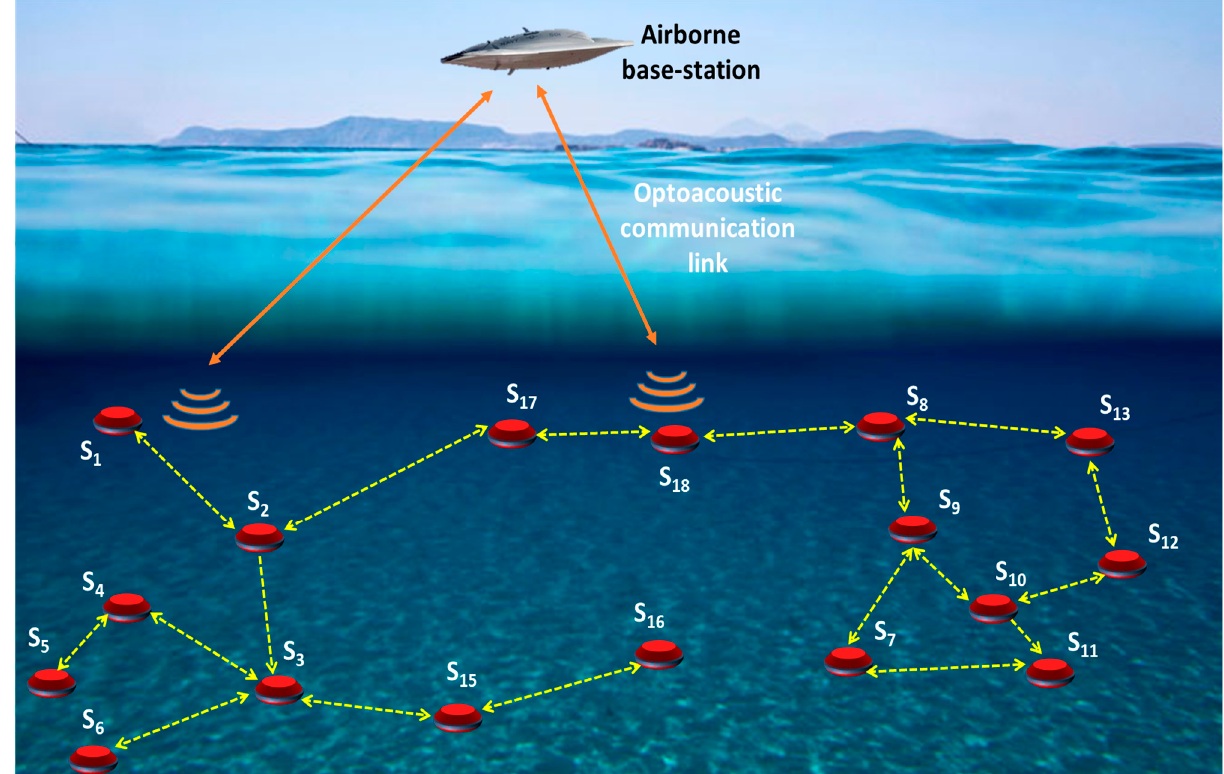
Figure 1. Underwater networking scenario showing nodes utilizing acoustic links to establish data routes to multiple destinations. The network is interfaced to an aerial vehicle through optoacoustic communication links.